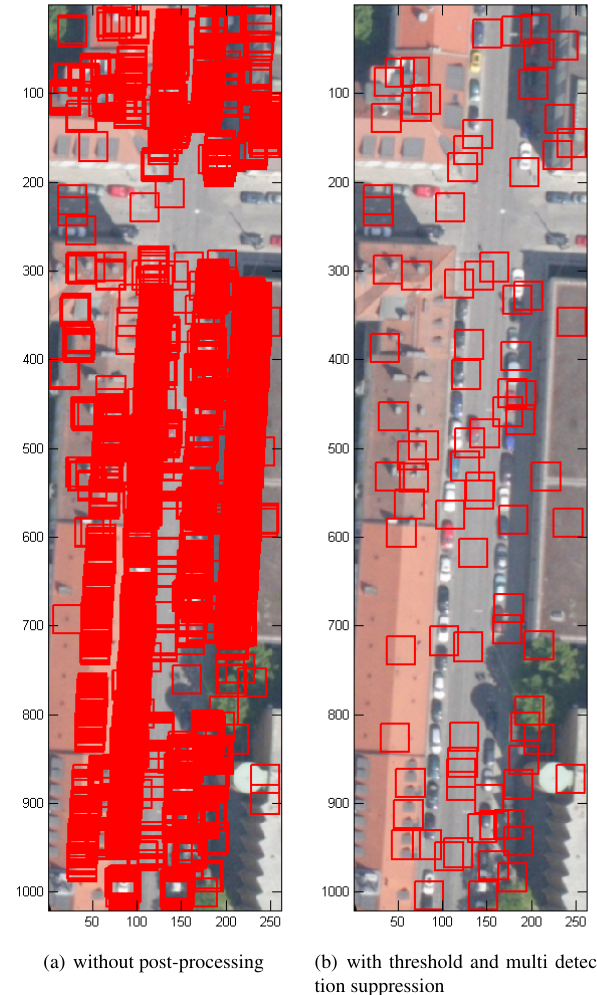
Figure 5: Result Haar-like